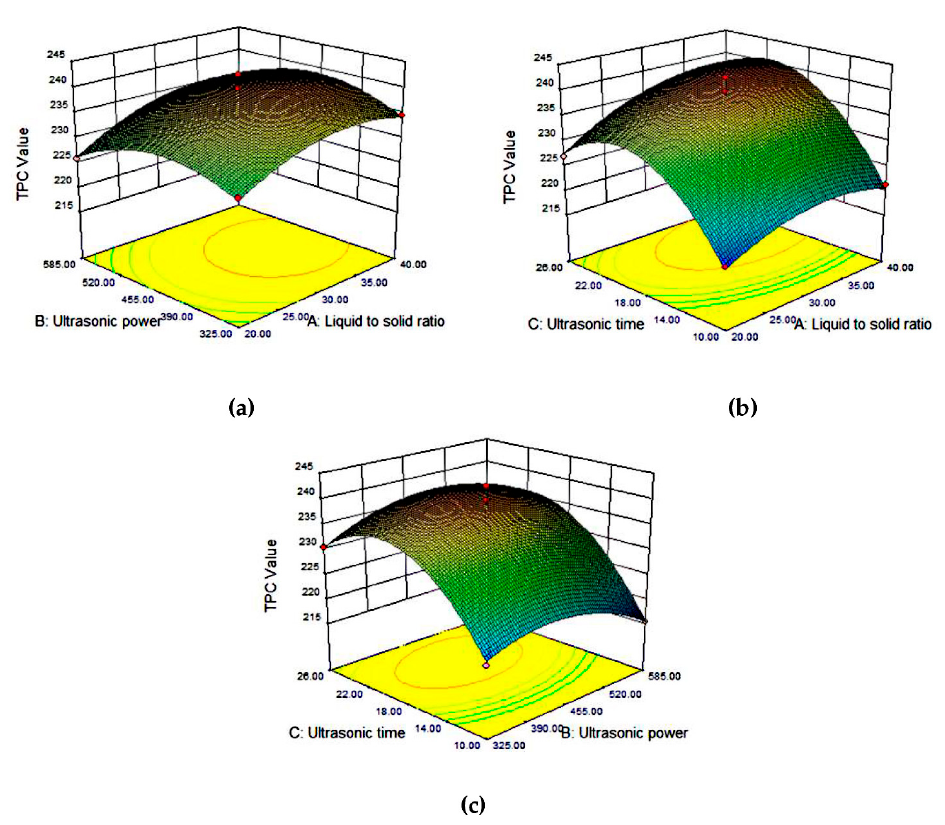
Figure 3. Response surface plots for the interactive effect of ( a ) liquid to solid ratio and ultrasonic power, ( b ) ultrasonic time and liquid to solid ratio, and ( c ) ultrasonic time and ultrasonic power, on the TPC.